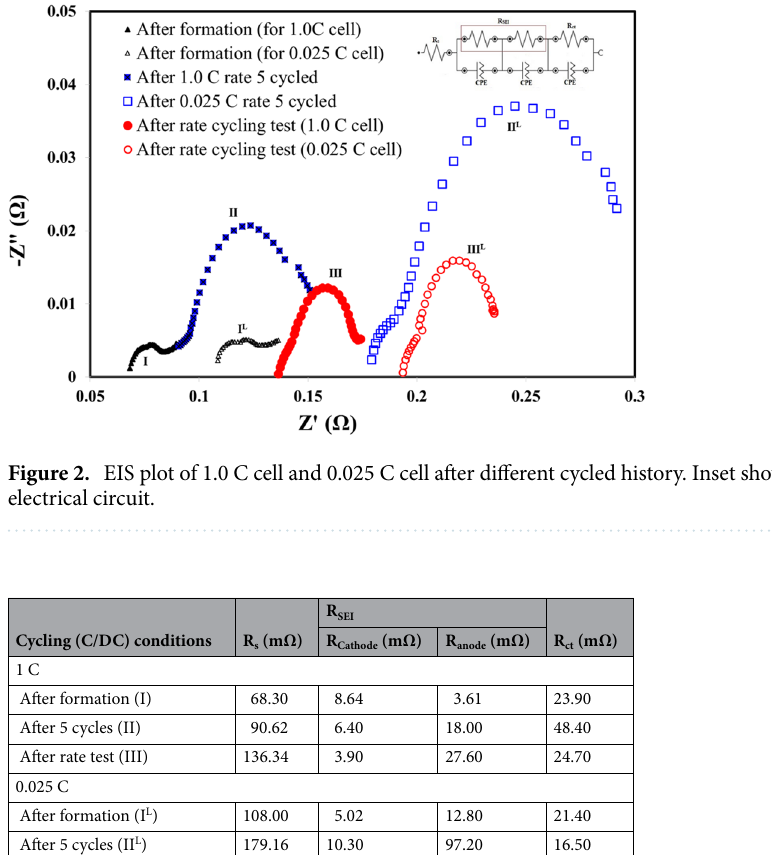
Table 1. The resistance values estimated from the equivalent circuits of EIS curves.